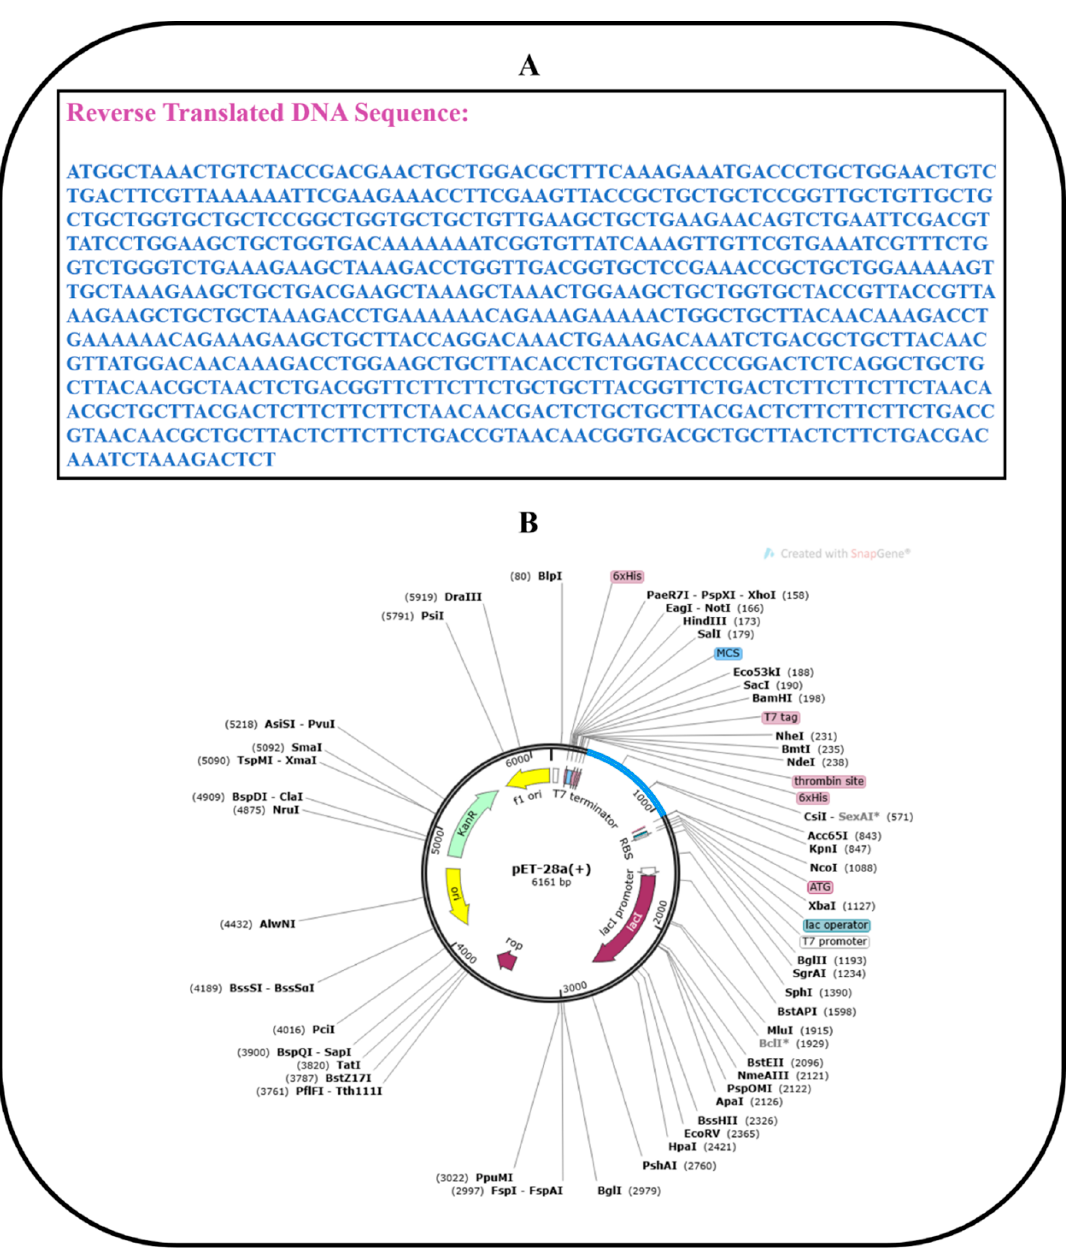
Figure 10. Codon optimization and in silico cloning. ( A ) Reverse-translated DNA sequence of MEV construct; ( B ) in silico cloning of MEV construct (shown in blue color) in the pET28a expression